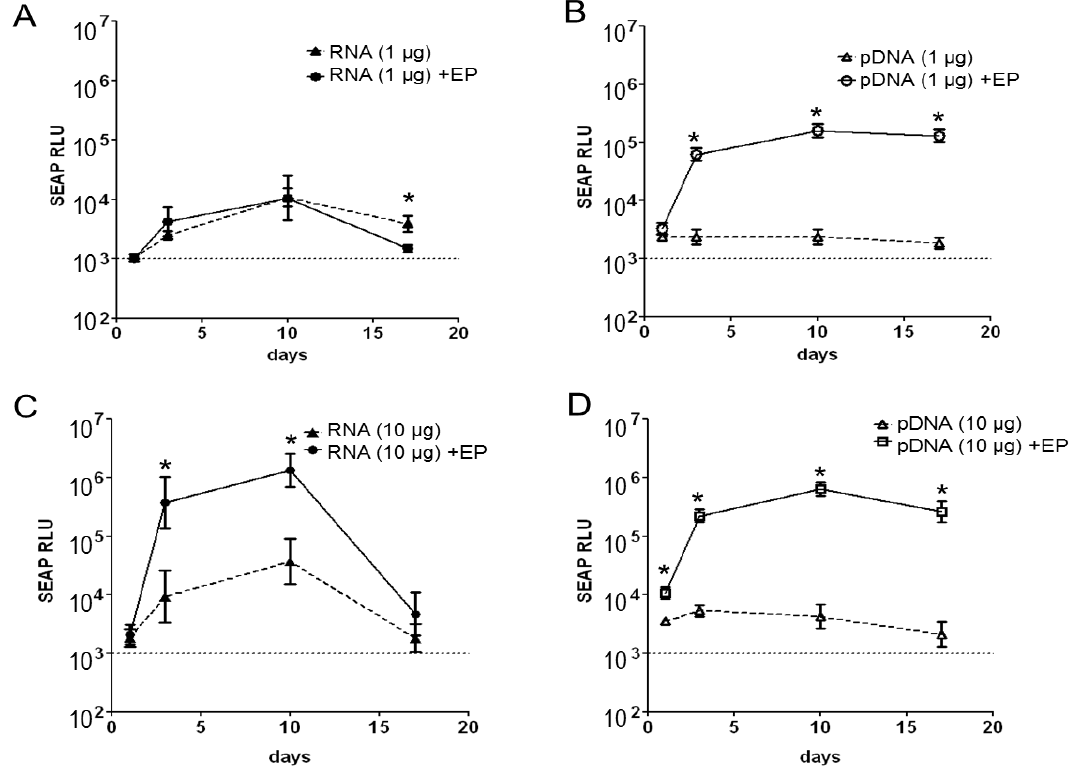
Figure 1. In vivo expression of secreted embryonic alkaline phosphatase (SEAP) after intramuscular njection of self-amplifying mRNA (RNA, 1 µg or 10 µg, panels A , C ) or pDNA (DNA, 1 µg or 10 µg, panels B , D ). The vectors were delivered by bilateral intramuscular injection with (+EP) or without electroporation. Serum SEAP expression was measured on days 1, 3, 10 and 17 after treatment, and represented as the log of mean relative luminescence (RLU) ± SEM, n = 5/group. * Statistically significant (student-t test, p <